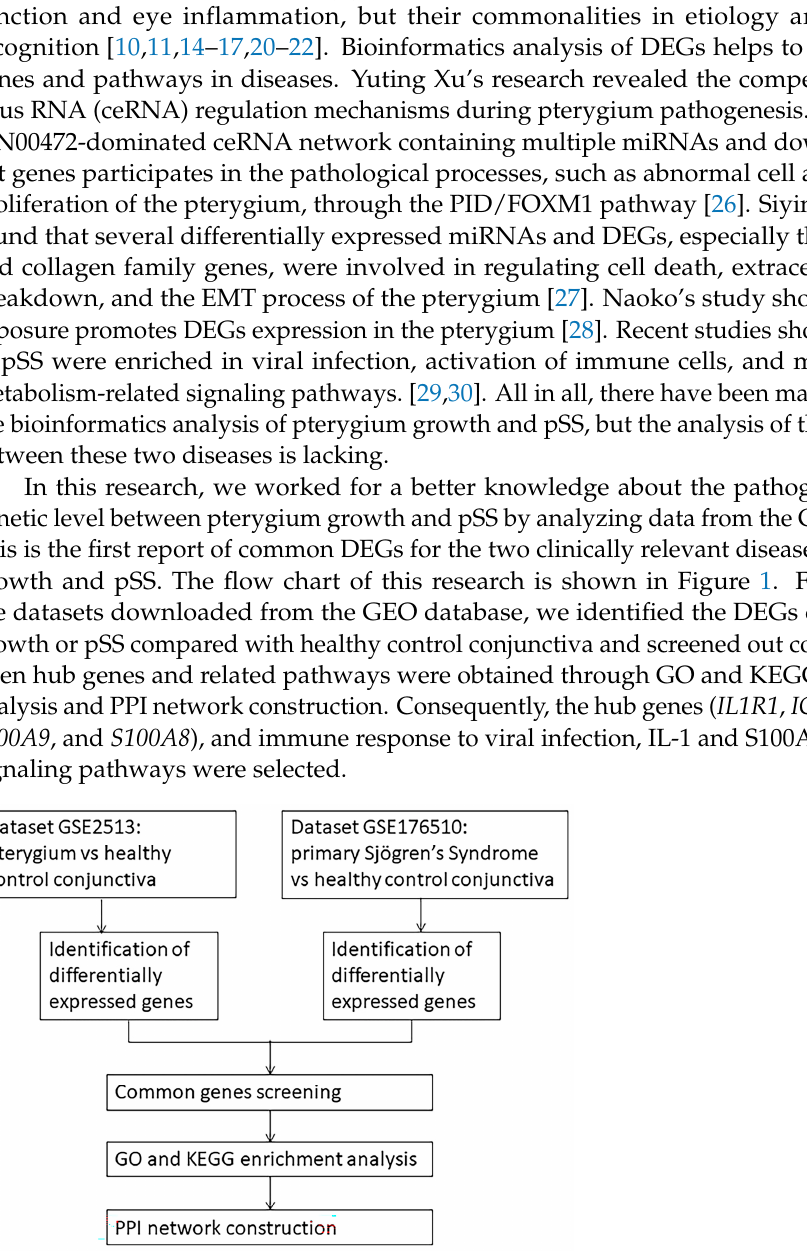
Figure 1. Workflow of this study. Dataset GSE2513 and GSE176510 was previously published in [Gene Expression Omnibus (GEO) database] at [https://www.ncbi.nlm.nih.gov/gds (accessed on 17 March 2020)] . GO: Gene Ontology. KEGG: Kyoto Encyclopedia of Genes and Genomes.